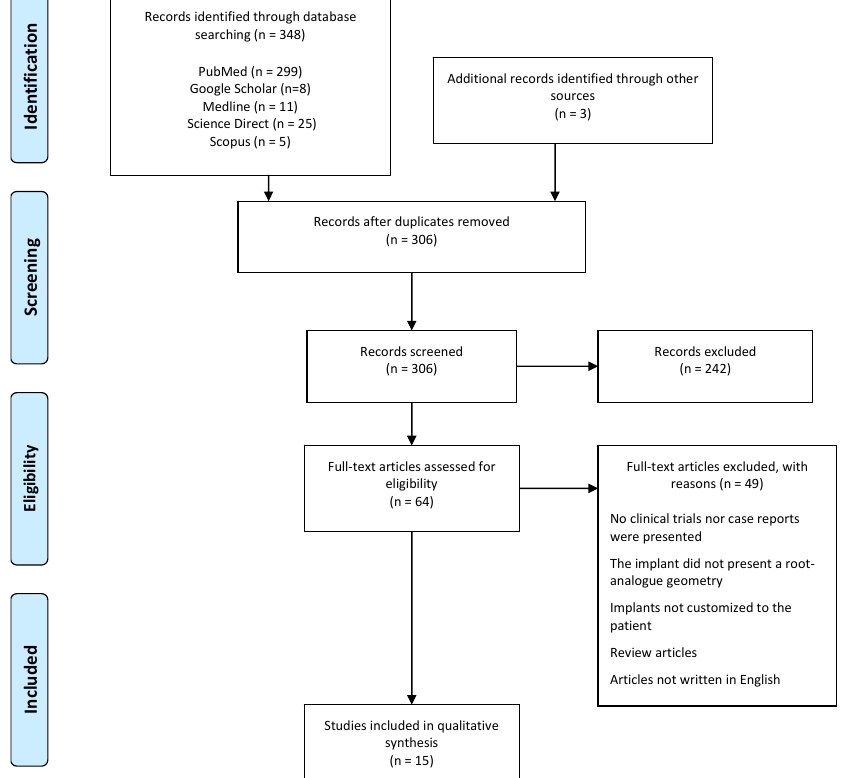
Figure 1. Search strategy flowchart, adapted from [16]. Table 1. Articles included in the review.